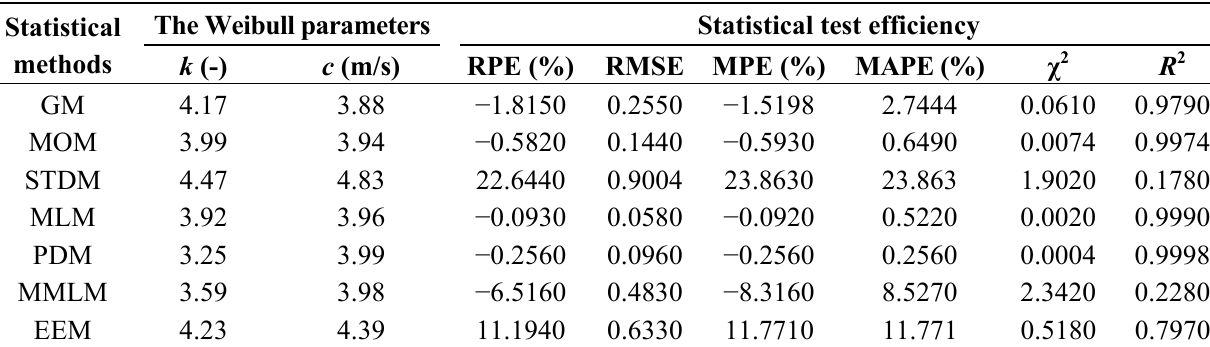
Table 7. The Weibull distribution analysis for Station-II at 30 m height.